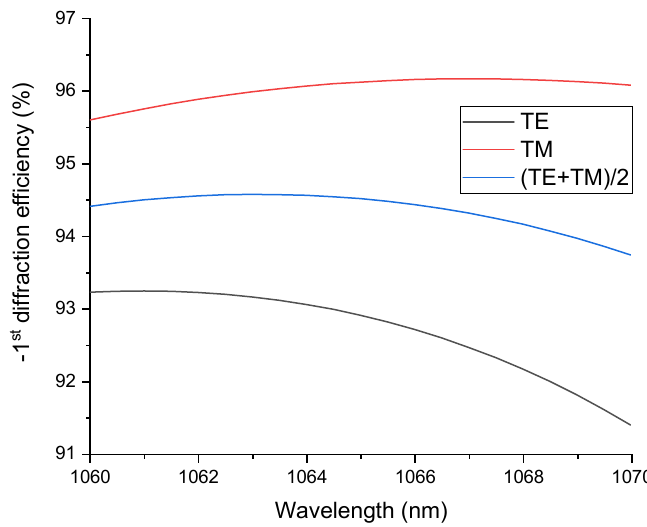
Figure 5. MDG diffraction efficiency at different wavelengths.